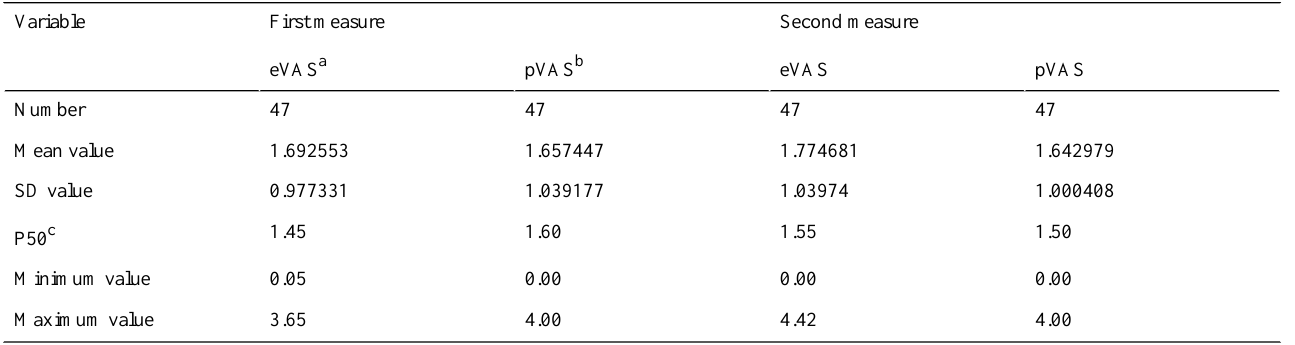
Table 1. Summary statistics (visual analog scale measurements) for children and adolescents.